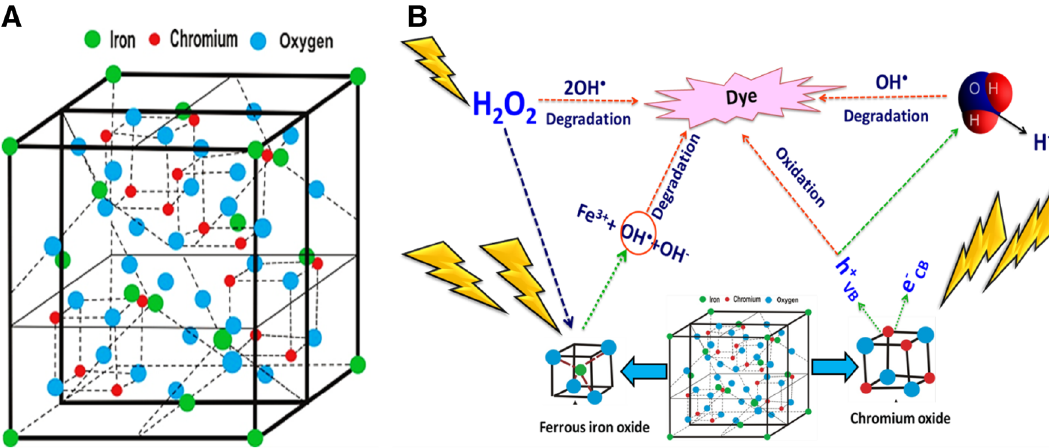
Fig. 2 a Crystal structure of Fe-chromite mineral, b mechanisms of photocatalytic degradation and photo-Fenton oxidation of dye by